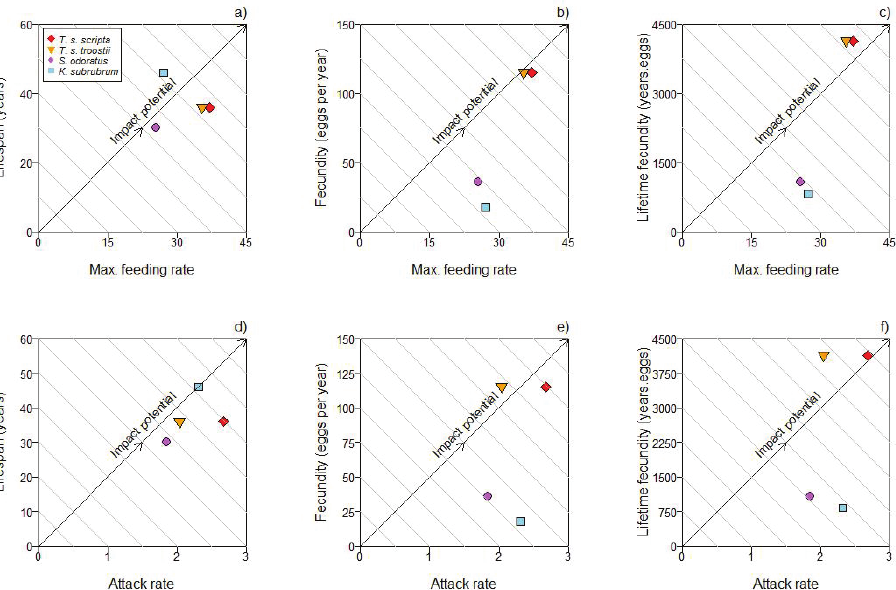
Figure 3. Biplots showing Relative Impact Potential of T. s. scripta , T. s. troostii , S. odoratus and K. sub- rubrum towards G. pulex prey. Impact potential calculated as a product of maximum feeding rate and lifespan ( a ), fecundity ( b ) and lifetime fecundity ( c ); then attack rate and lifespan ( d ), fecundity ( e ) and lifetime fecundity ( f ). Impact increases from bottom left to top